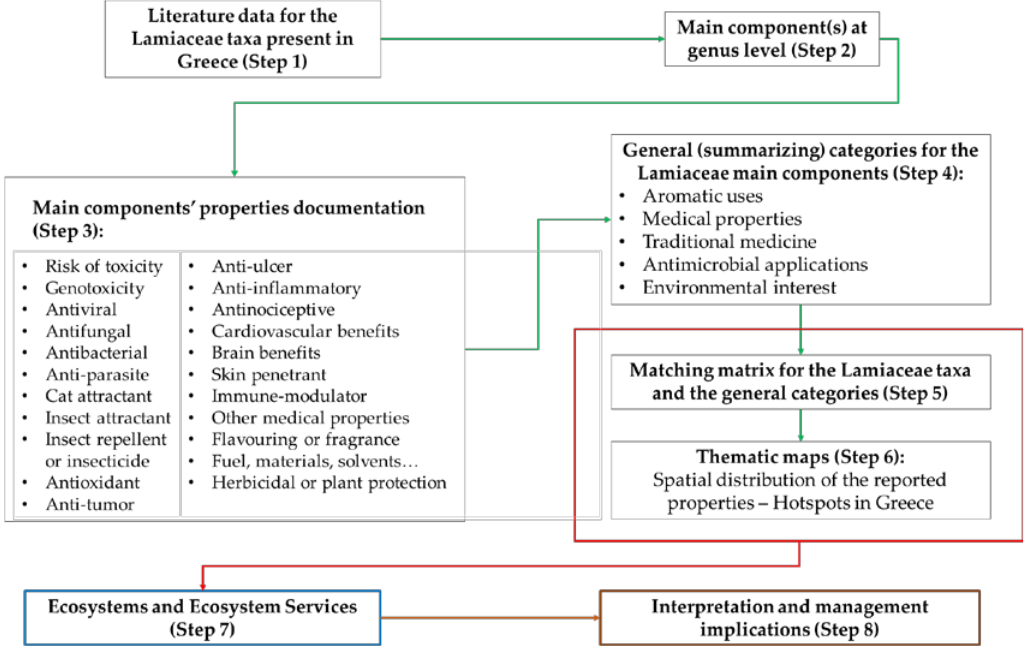
Figure 1. Flowchart of the study.